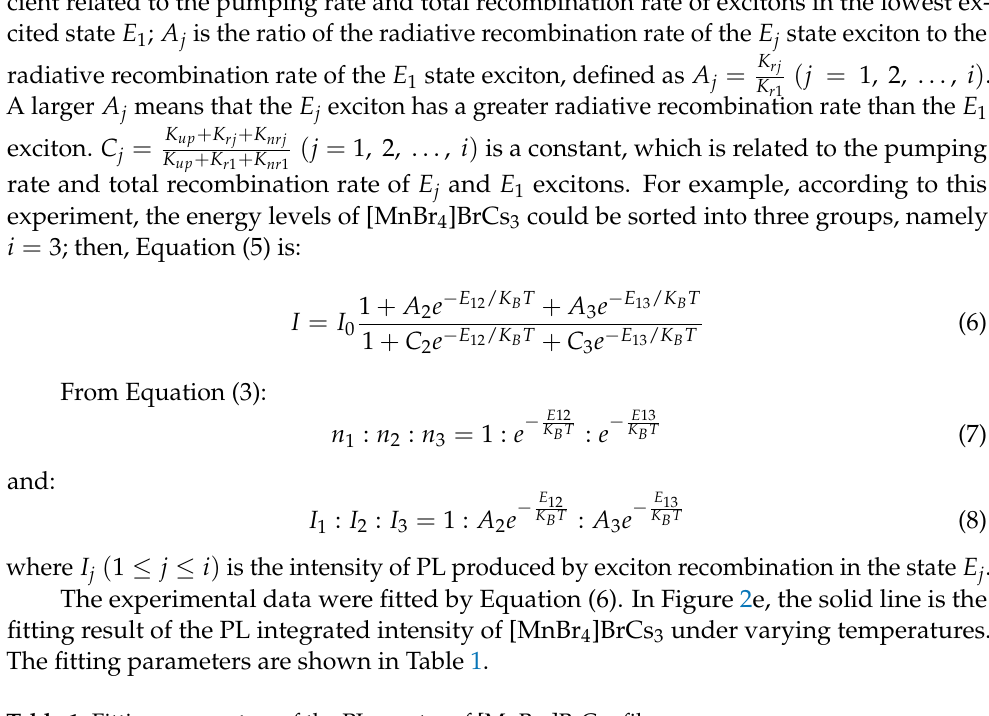
Table 1. Fitting parameters of the PL spectra of [MnBr 4 ]BrCs 3